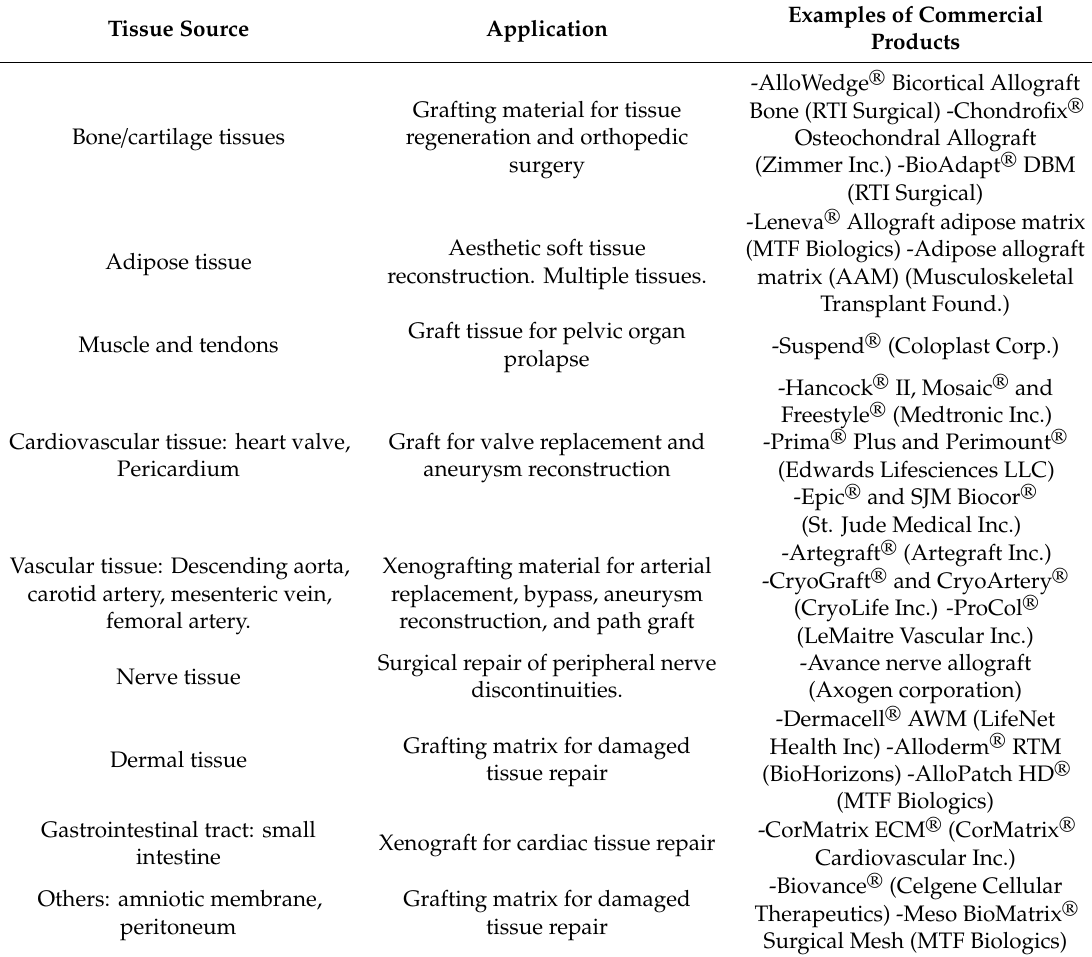
Table 2. Some examples of commercially available tissue-derived ECM products provided by tissue